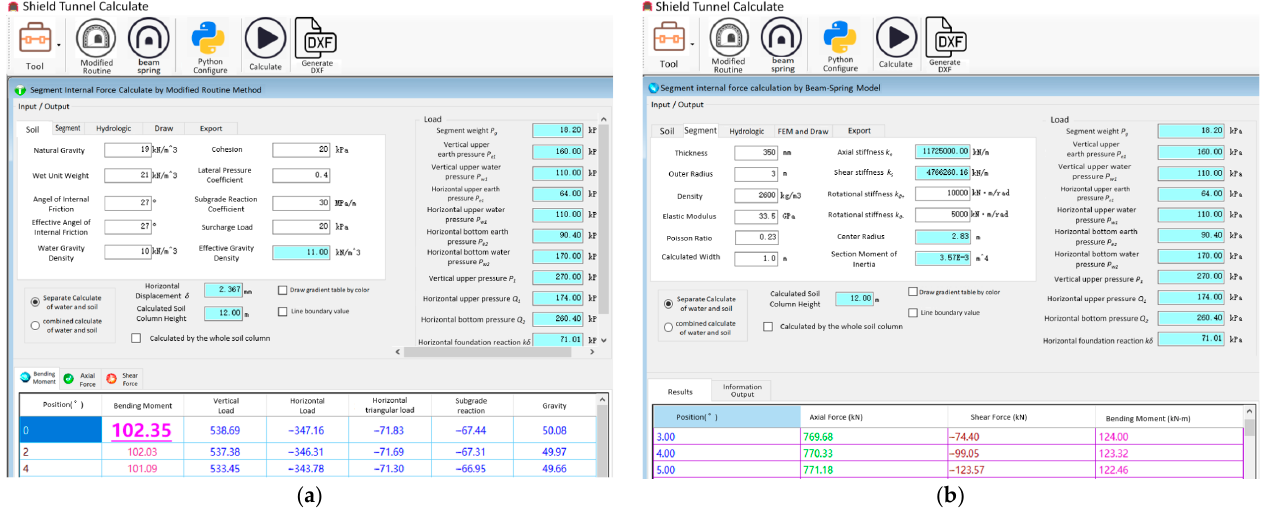
Figure 9. Shield tunnel calculation software. ( a ) Modified routine method module. ( b ) Beam–spring method module.